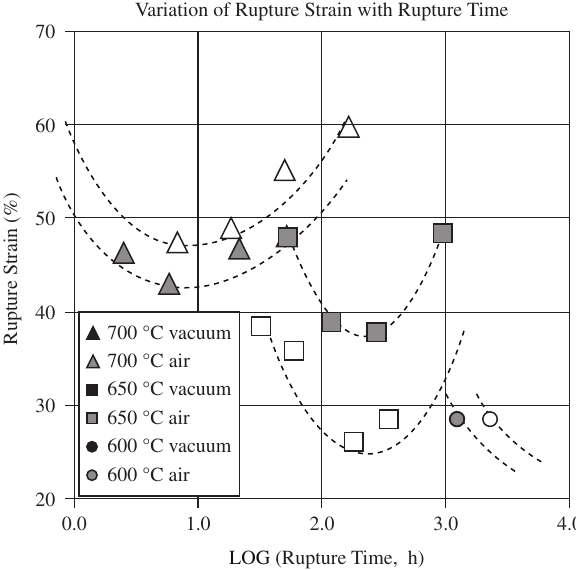
Figure 9. Variation of rupture strain with rupture time for 2.25Cr-1Mo steel, in air and vacuum.